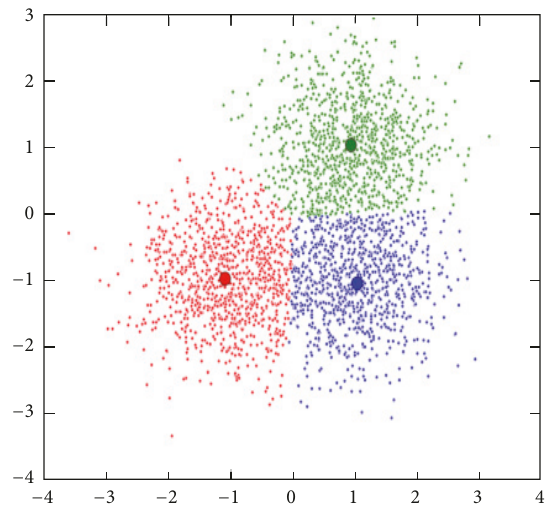
Figure 1: 𝐾 -means clustering result with 𝑘 = 3